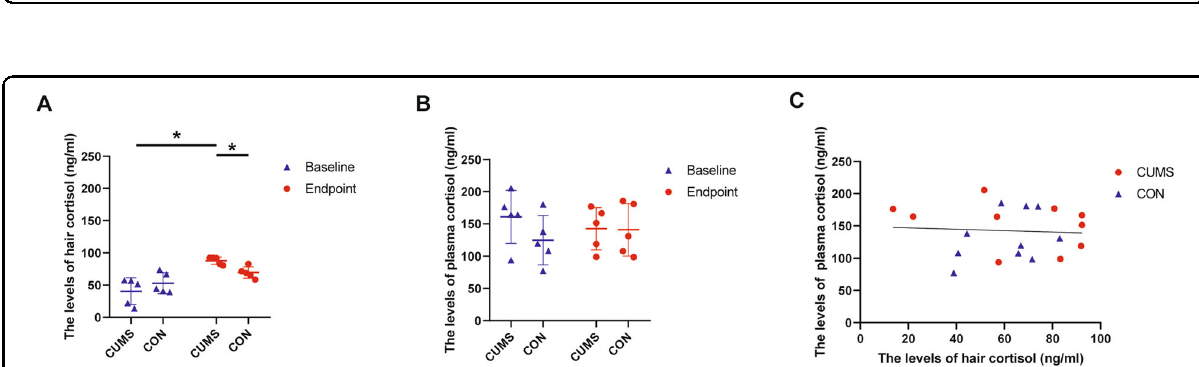
Fig. 4 The level of cortisol. The level of hair ( A ) and plasma ( B ) cortisol in CUMS and CON groups at baseline and endpoint (after fi ve stress cycles); the correlationship between hair and plasma cortisol level ( C ). * P <